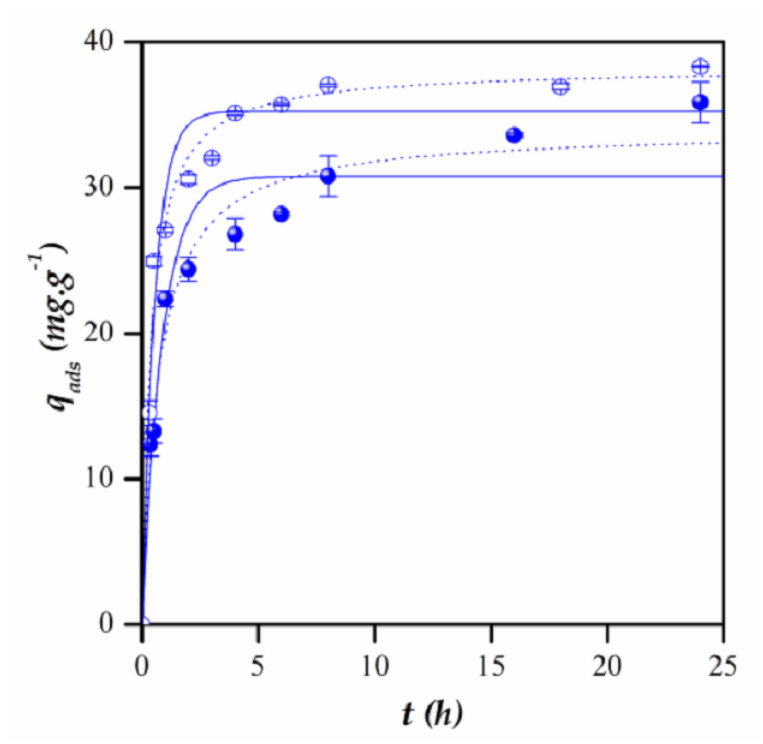
Figure 7. Kinetic adsorption data for TC ( ) and CPX (O) on Si-PILC 75. Solid lines represent a pseudo-first-order model and dot lines represent pseudo-second order